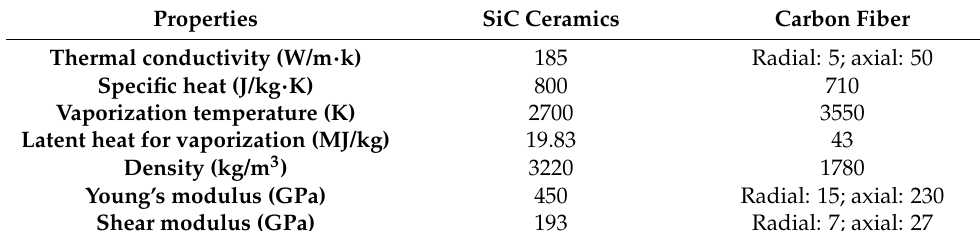
Table 2. Characteristics of the carbon fiber and SiC matrix [35,36].